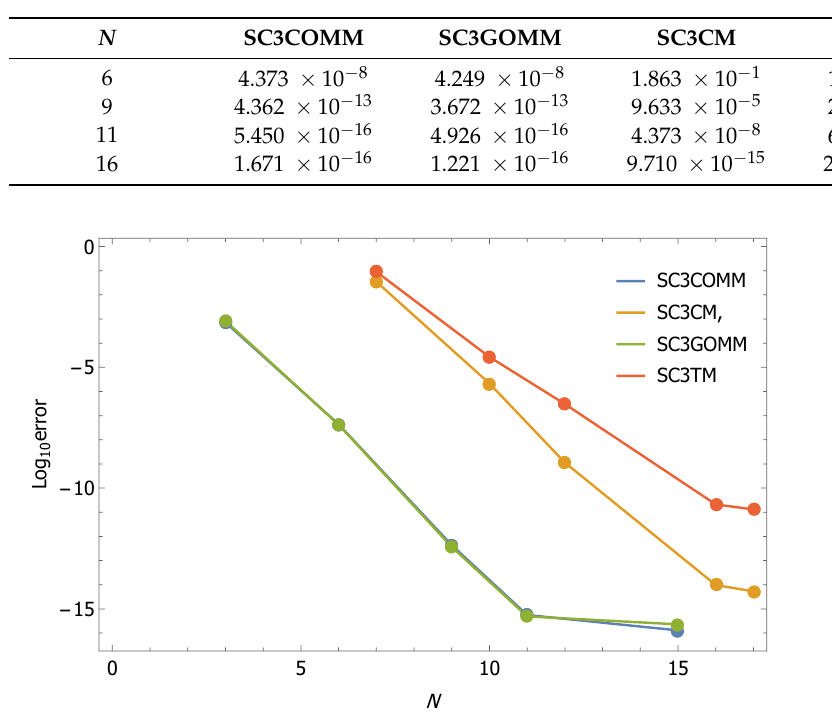
Table 7. Maximum absolute error of Example 5.